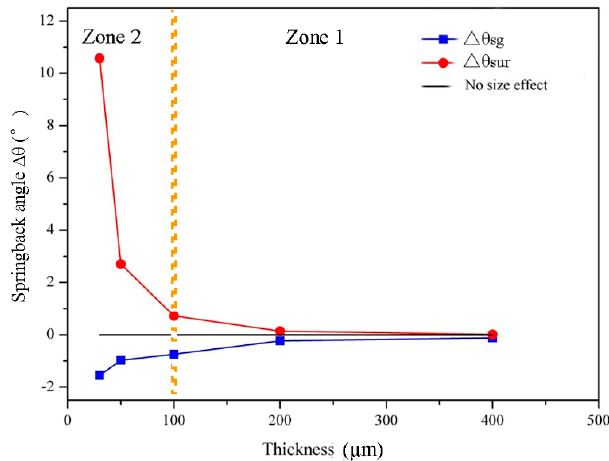
∆ θ ∆ θ sur and sg with foil